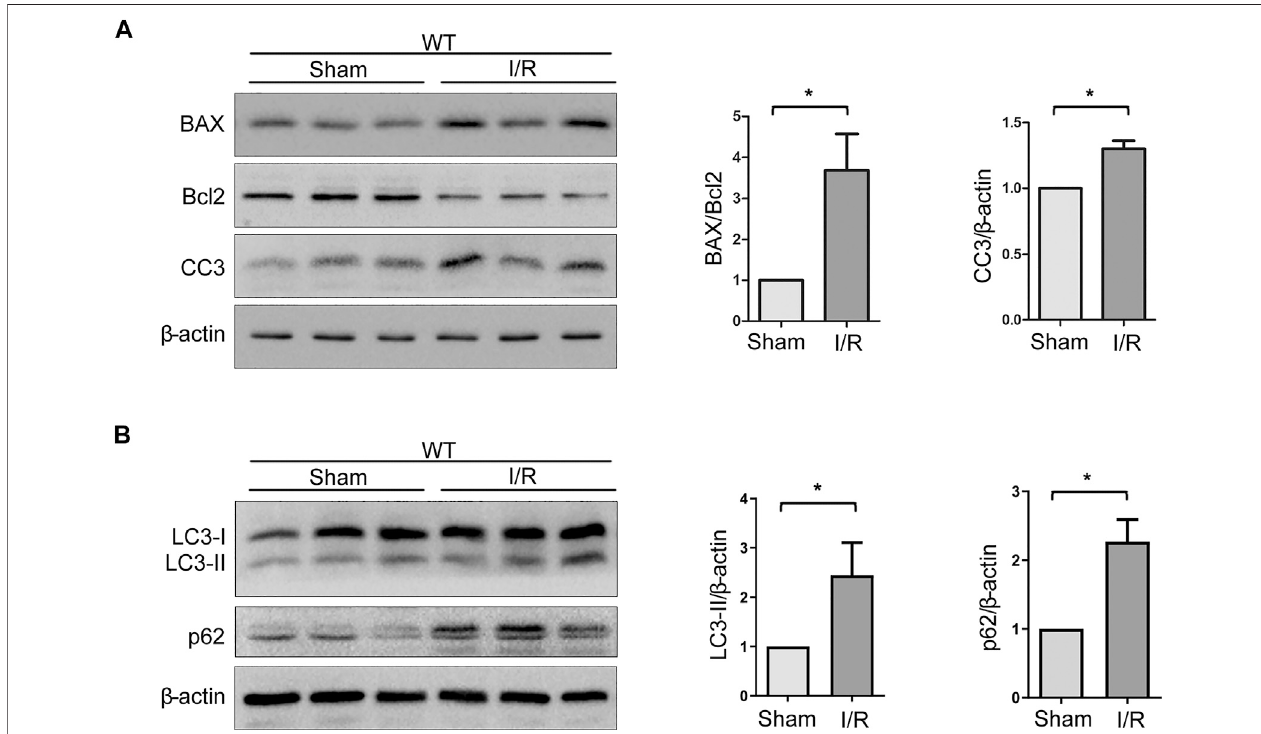
FIGURE 3 | Expressions of autophagy- and apoptosis-related proteins are increased upon IRI. (A) Representative western blot images of BAX, Bcl-2, and CC3 expressionsinrenaltissuelysatesofWTmicesubjectedtoshamorI/Roperations.Barsrepresentmean ± SEM, n (cid:2) 3,* p < 0.05. (B) Representativewesternblotimages of LC3-II and p62 expressions in renal tissue lysates of WT mice subjected to sham or I/R operations. Bars represent mean ± SEM, n (cid:2) 3, * p <